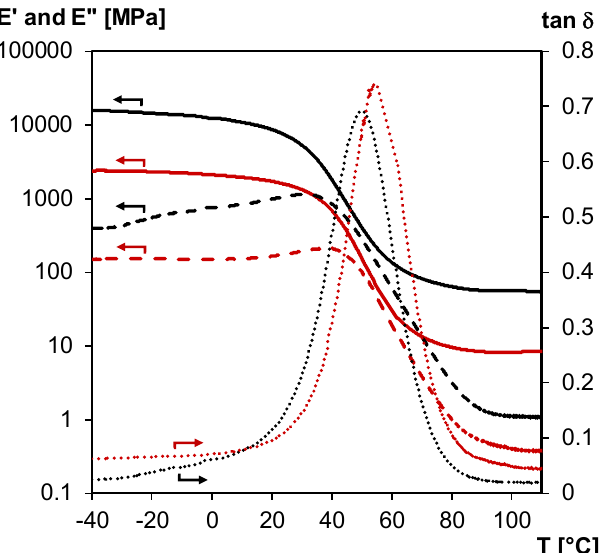
Figure 14. DMA of the 3M-F375PMA, measured on film in tension mode (undamaged, black ) and on powder rectangular bar in 3-point bending mode (healed at 20 ◦ C after damage, red ). Storage modulus E’ ( full lines ), loss modulus E” ( dashed lines ) and tan δ ( dotted lines ).